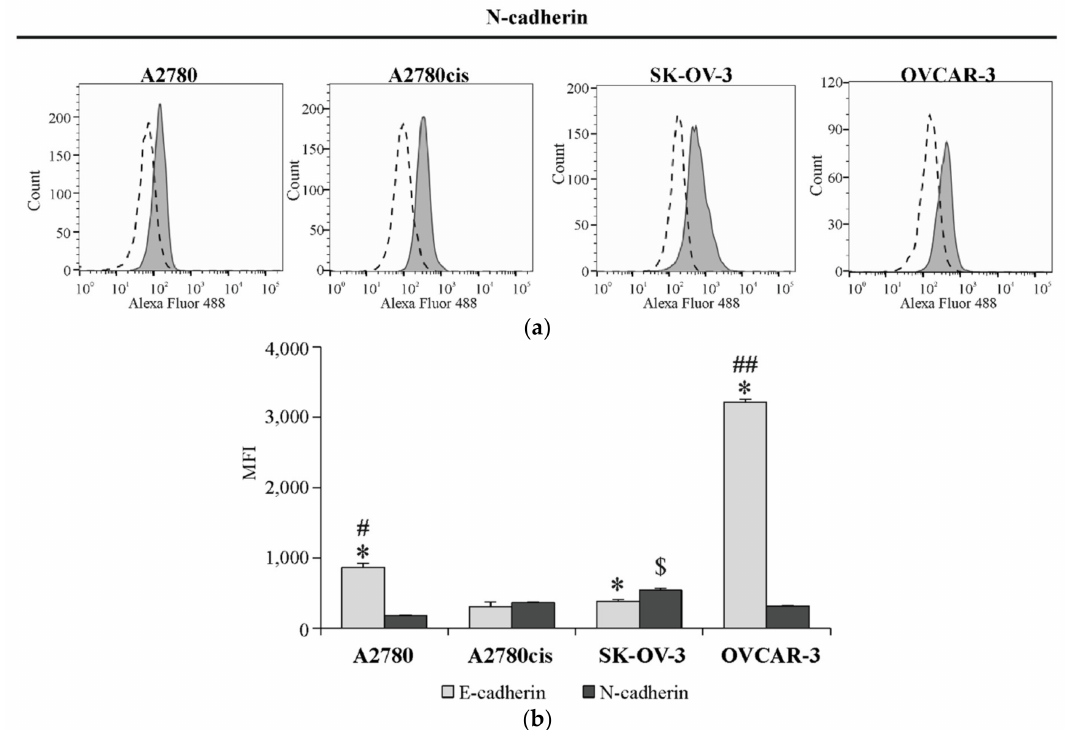
Figure 3. The basal level of E-cadherin and N-cadherin in A2780, A2780cis, SK-OV-3 and OVCAR-3 cell lines. Surface expression of both cadherins was determined by staining cells with antibodies, targeting either E-cadherin (Abs conjugated with PE fluorochrome) or N-cadherin (Abs conjugated with Alexa Fluor 488 fluorochrome) and measuring the intensity of fluorescence with the use of flow cytometry. ( a ) Representative histograms of E-cadherin and N-cadherin expression (grey graph) in regard to appropriate isotype controls (dashed line graph) are shown. ( b ) The acquired data are presented as the mean medium fluorescence intensity (MFI) ± SD from four independent experiments ( n = 4). * Statistically significant difference in E-cadherin and N-cadherin level: E-cadherin vs. N-cadherin in A2780, A2780, SK-OV-3 or OVCAR-3 cell line, p ≤ 0.03 (Mann–Whitney U test test). # Statistically significant difference in E-cadherin level: A2780 vs. A2780cis